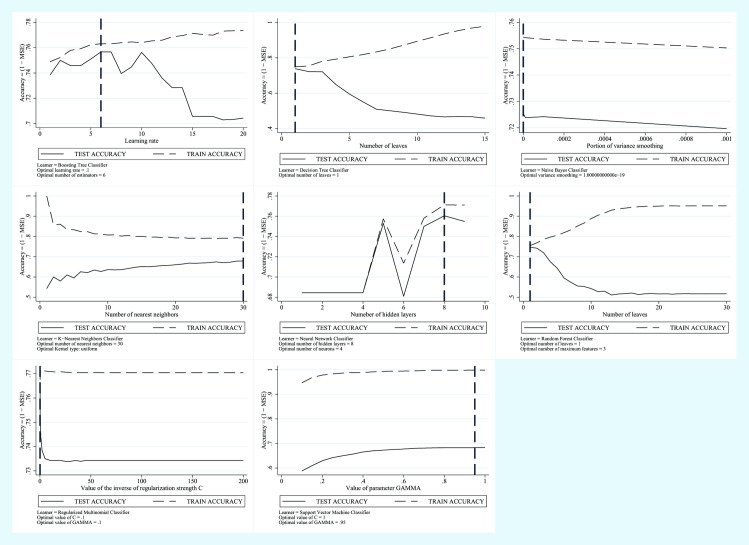
Machine learning applied to NAFLD diagnosis.Training Error vs Test Error for the FLI plus Glucose plus Age plus Sex Predictive Model.